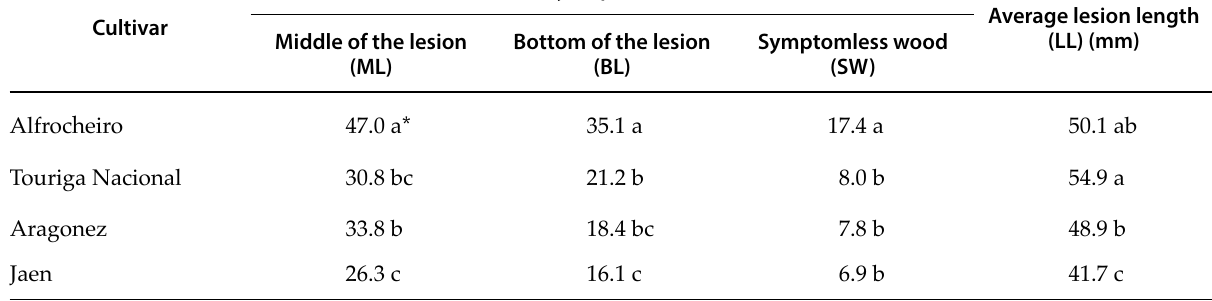
Table 1. Mean proportions (%) of Phaeomoniella chlamydospora colonies recovered from middle of lesion, bottom of lesion or from symptomless wood, and mean lesion lengths, recorded for four grapevine cultivars inoculated with three P. chla- mydospora isolates in three trial years.